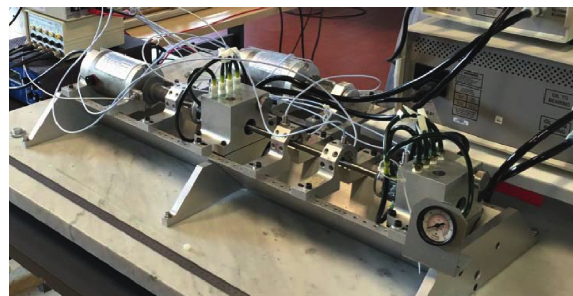
Figure 6: Rotor assembly mounted with custom shaft in config- uration